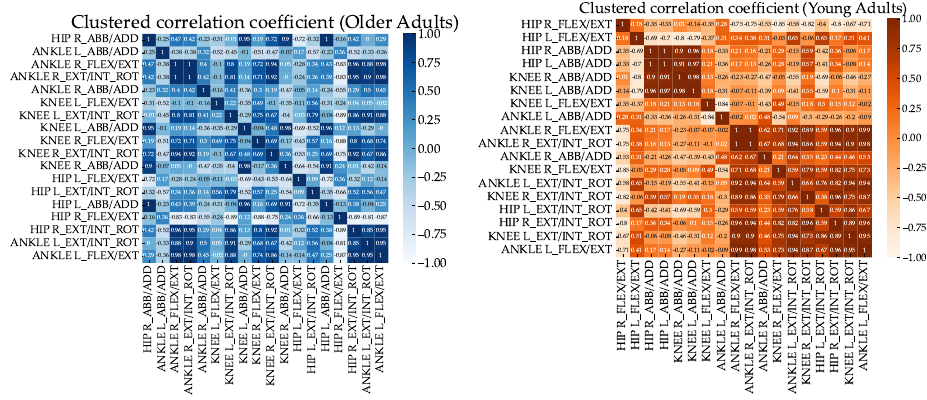
Figure 4. Clustered correlation heatmap for the older and younger